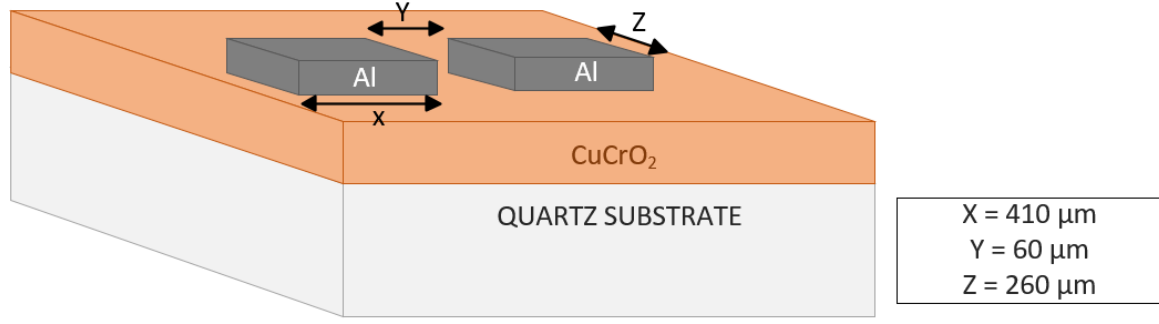
Figure 1. Diagrammatic representation of contact pads used for electrical measurements.